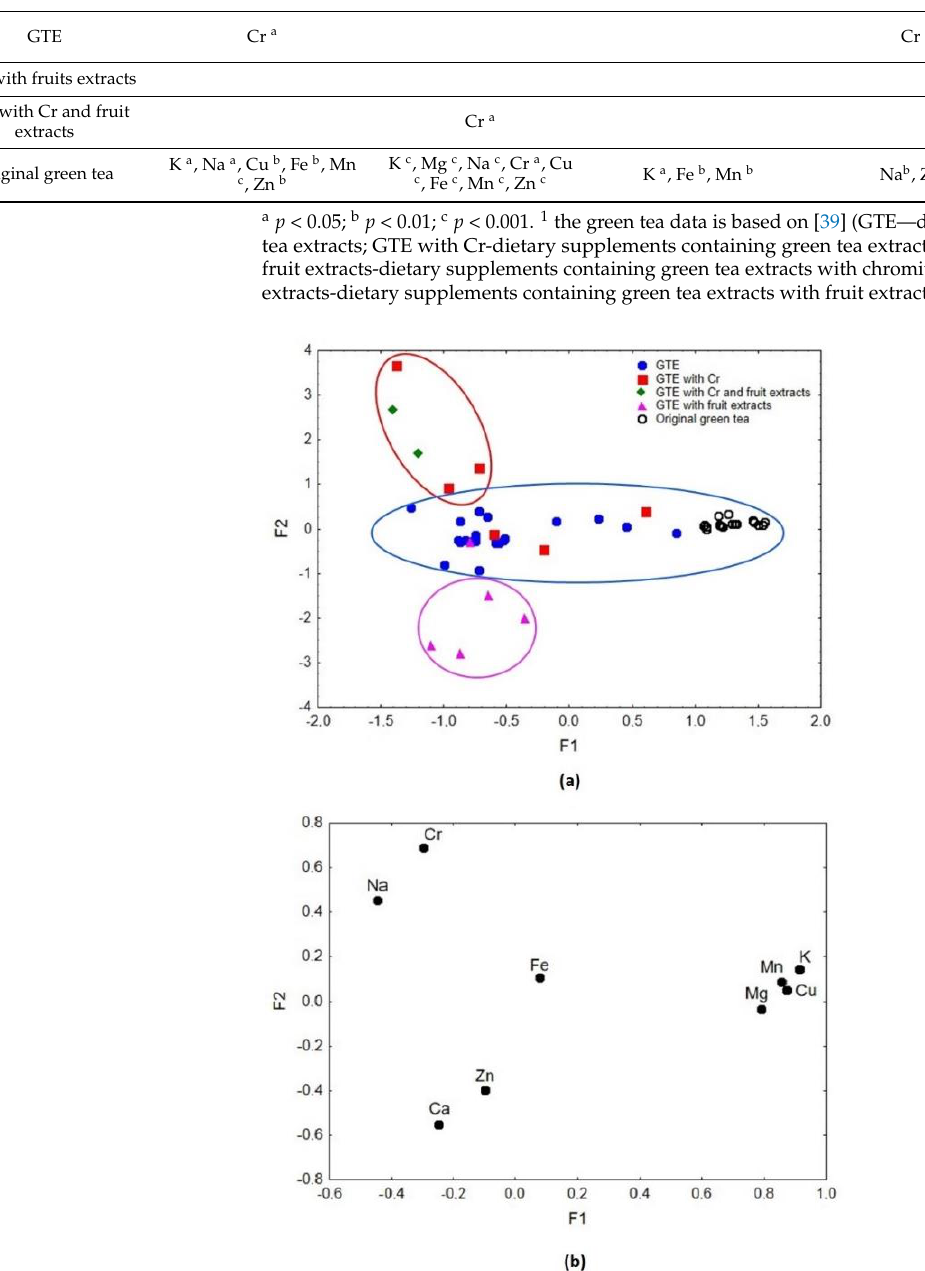
Table 8. Evaluation of the manufacturer’s declaration for Cr content.